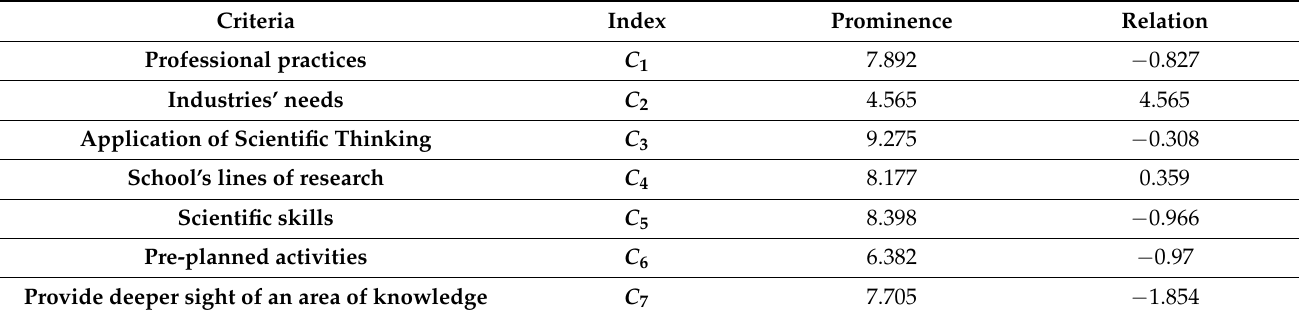
Table 13. DEMATEL